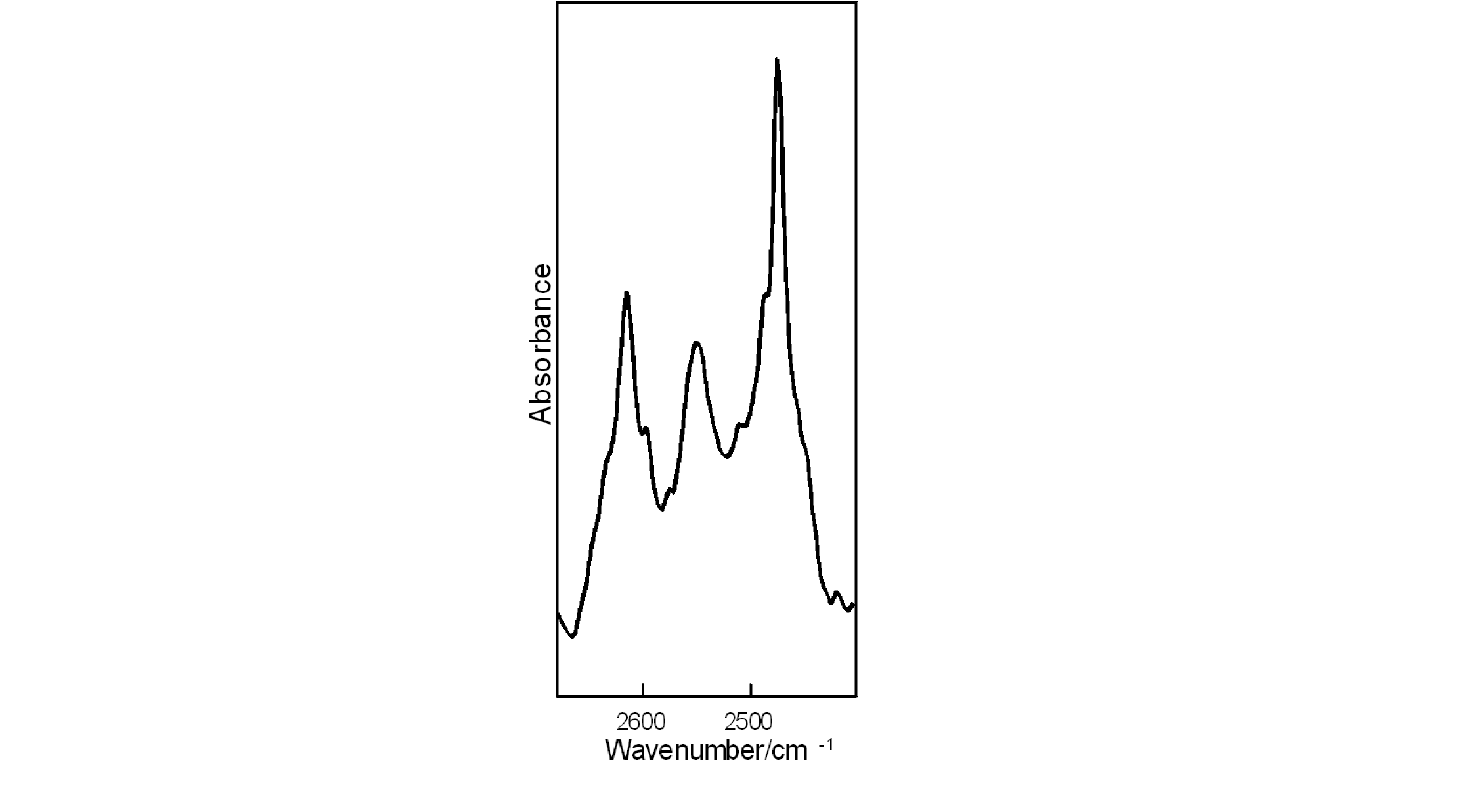
Fig. 5 The O{D stretching region in the LNT di¬erence IR spectrum of partially deuterated analogue of K 3 (sac) 3 ¢ 2H 2 O (the spectrum is obtained by subtracting the LNT spectrum of the protiated species from the corresponding spectrum of the sample deuterated to w D º 3